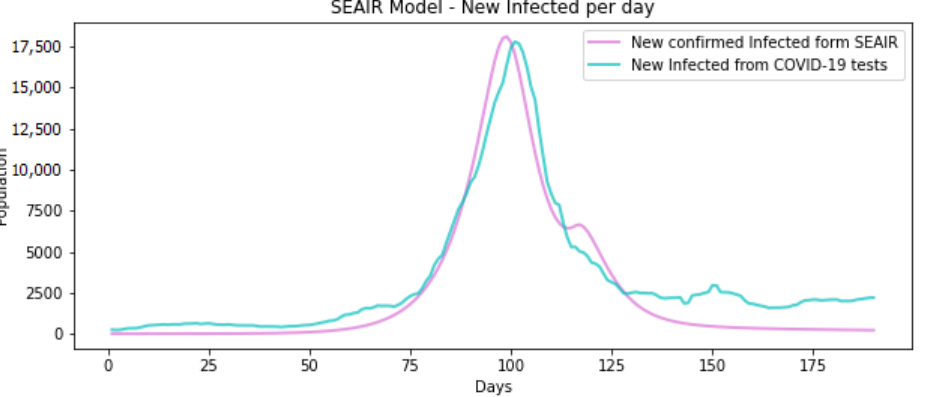
Figure 9. Comparison of newly infected people between SEAIR model and COVID-19 tests in Belgium. Second